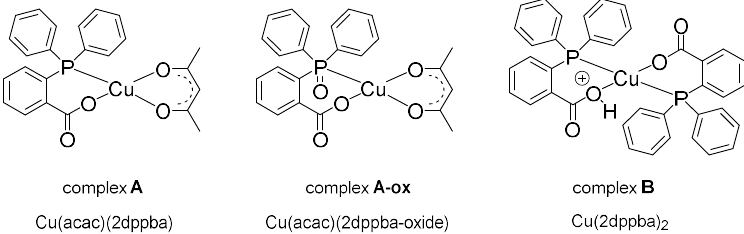
Figure 32. Chemical structures of copper complexes resulting from ligand exchange by 2-dppba with Cu(acac) 2 .